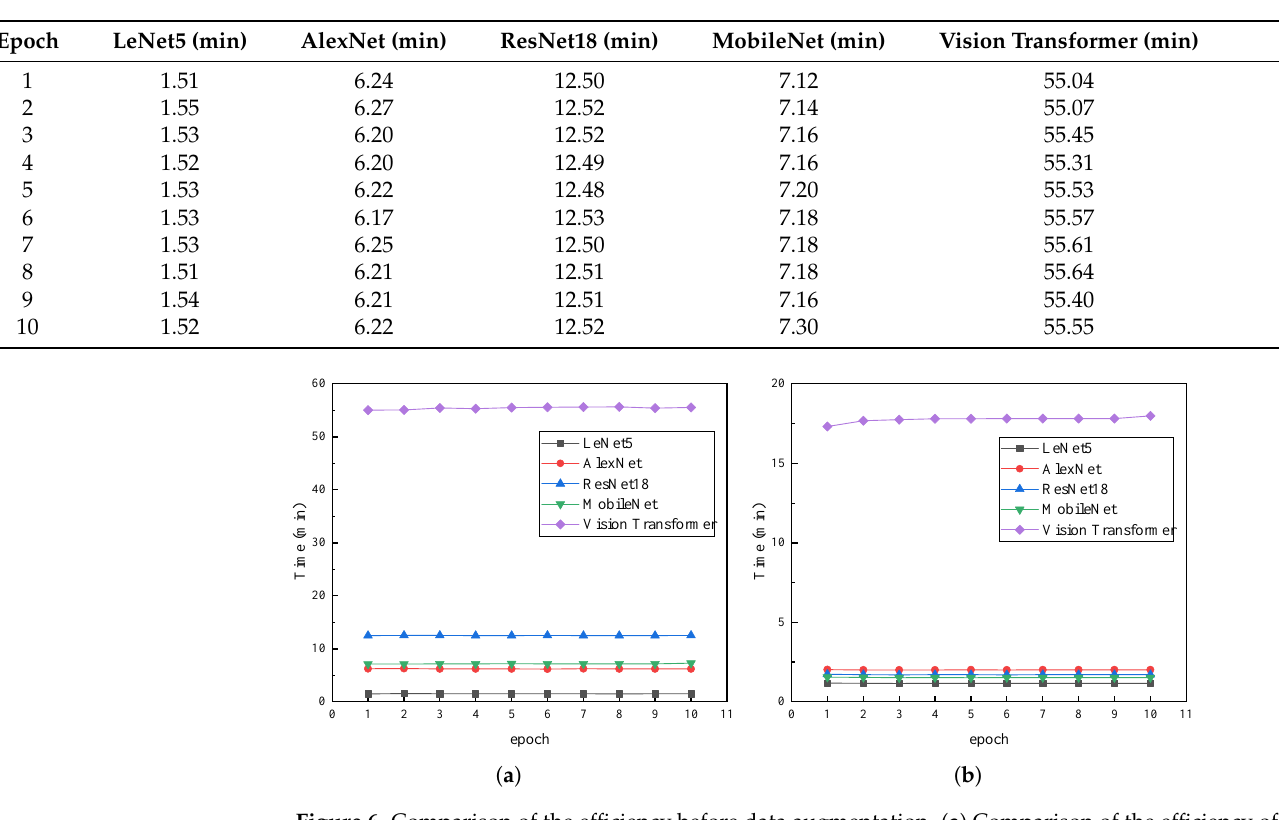
Table 7. Computational efficiency of per epoch operation for each model before data augmentation and before GPU loading.